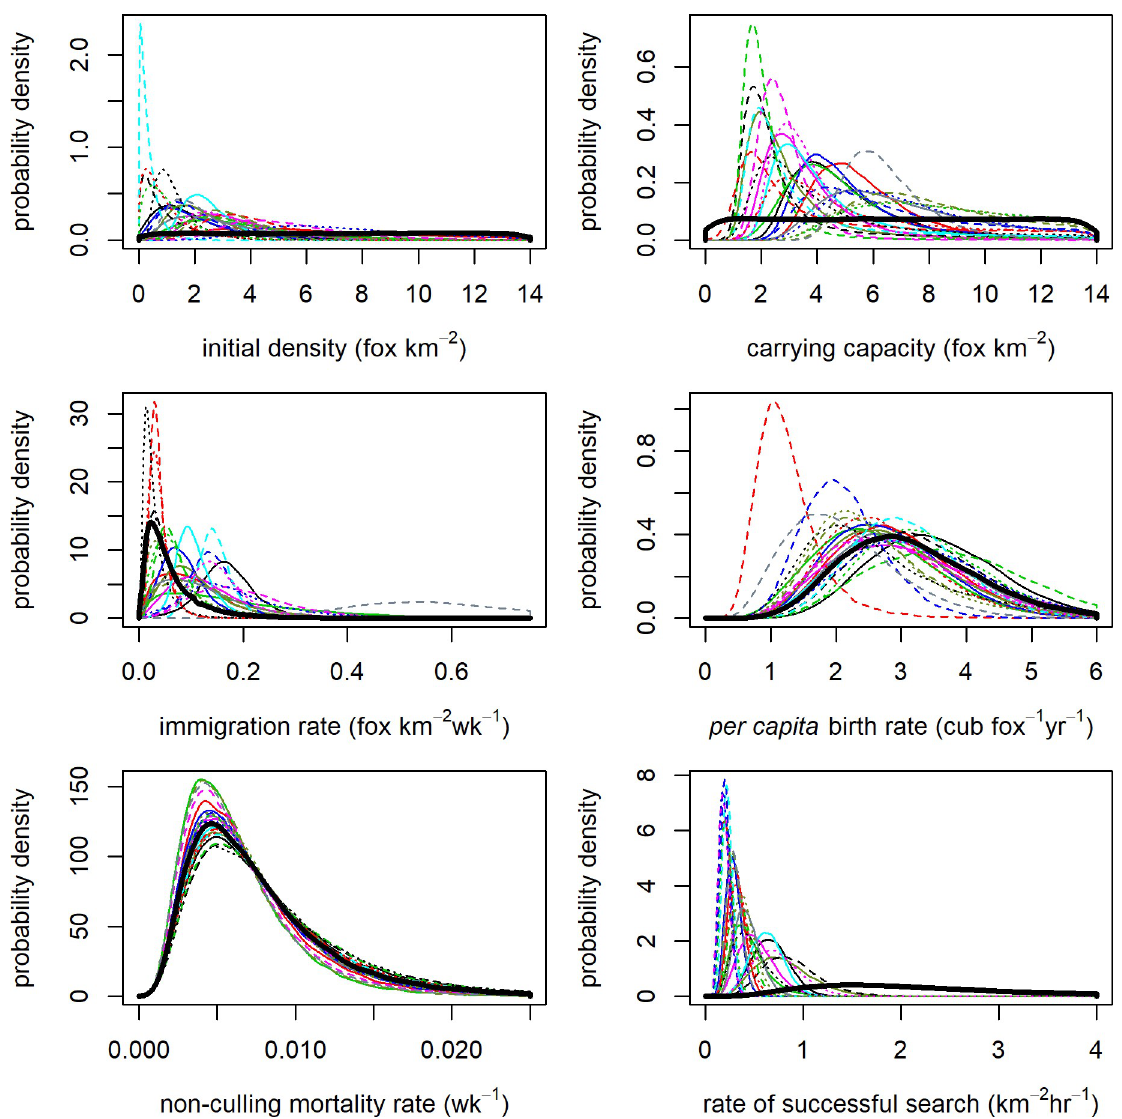
Fig 2. Marginal posterior probability distributions for the estimated parameters from the 22 estates: N 0 (initial density), K (carrying capacity), v (immigration rate), r ( per capita birth rate), M (non-culling mortality rate), and d (rate of successful search). Each estate is represented by the same line type and colour combination in all panels. The prior probability distribution for each parameter is shown by the bold black line. Differences between posteriors and priors indicate updating of parameter estimates through fitting the model to the